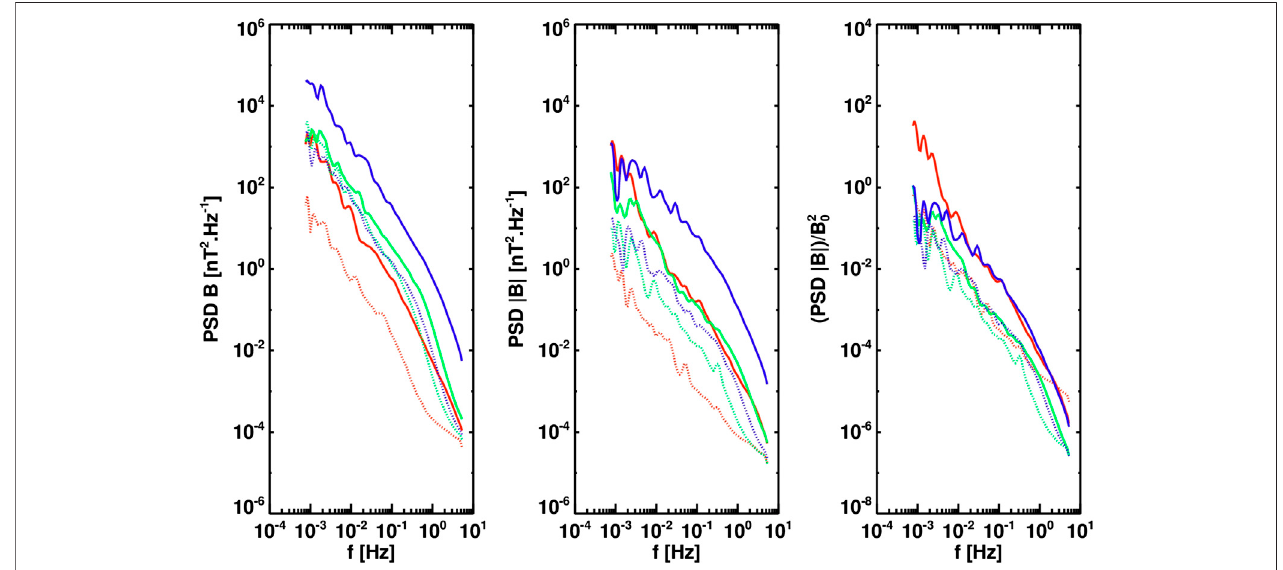
FIGURE 5 | Left: Trace power spectral densities of magnetic fi eld fl uctuations for upstream (dashed) and downstream (solid) intervals of S1 (red), S2 (green), and S3 (blue); middle: power spectrum of magnetic fi eld magnitude fl uctuations, and right: the same power spectrum but normalized to the average | B | in the particular